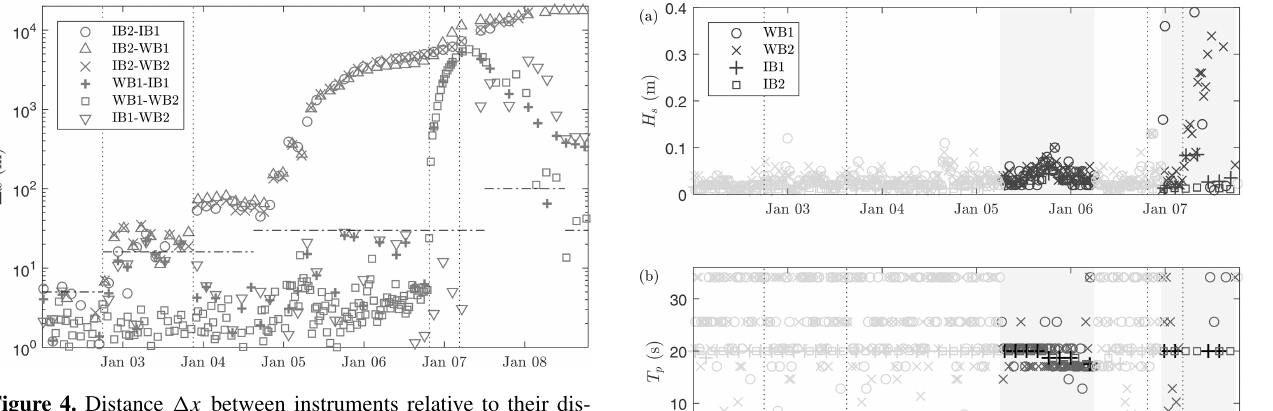
Figure 4. Distance (cid:49)x between instruments relative to their dis- tance at the time of deployment; i.e. (cid:49)x is taken initially equal to 0, and any change to (cid:49)x indicates relative motion between the instru- ments. Vertical dashed lines indicate instances of sea ice break-up: (2 January 2020 at 18:00) all instruments start drifting due to break- up of large ice mass; (3 January 2020 at 21:00) IB2 separates from the large ice mass (see also Fig. 3c); (6 January 2020 at 19:30) WB1 splits from WB2 and IB1; (7 January 2020 at 04:30) the ice floe holding WB2 and IB1 breaks due to waves generated by the storm depicted in Fig. 2b. Horizontal dashed lines refer to the uncertainty level induced by GPS accuracy and interpolation error, where the latter increases with the drift speed of the instruments.